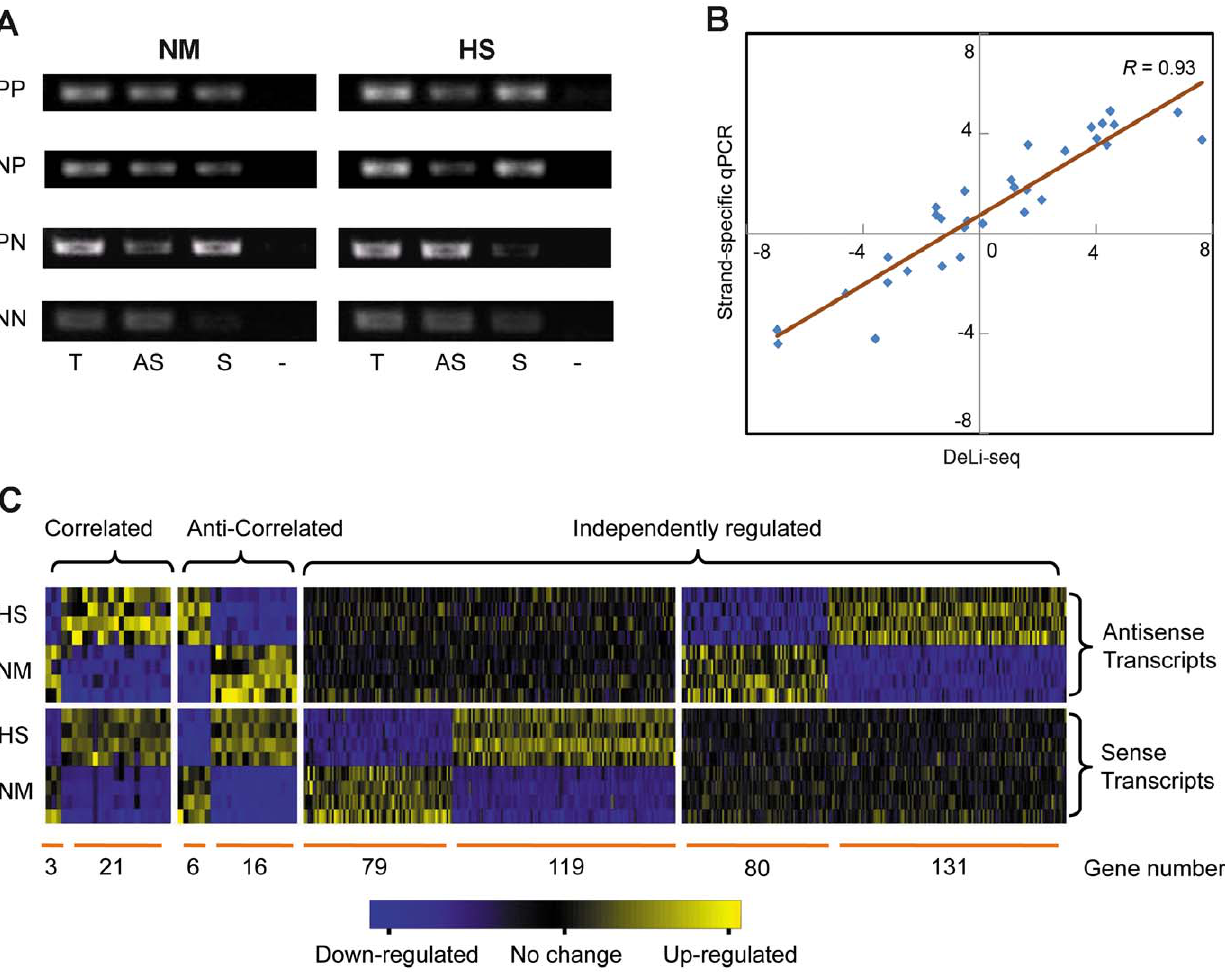
Figure 3. Differentially expressed sense and antisense transcripts. (A) Strand-specific RT-PCR results of four loci selected for validation. PCR products specific to antisense (AS) or sense (S) transcripts are shown. Positive control (T; RT with two gene-specific primers) and negative control (-; no primer at RT step) are also included. PP: S $ AS in both normal (NM) and heat shock (HS) conditions; PN: S $ AS in NM and S , AS in HS; NP: S , AS in NM and S $ AS in HS; NN: S , AS in both NM and HS. (B) Correlation between DeLi-seq and strand-specific qPCR. The log 2 (S/AS) values obtained by DeLi-seq (X axis) and the D Ct values between sense and antisense transcripts determined by quantitative strand-specific RT-PCR (Y axis) were used to compute the correlation coefficient ( R ). (C) Sense and antisense transcripts are either coordinated (correlated or anti-correlated) or independently regulated. The number of genes in each category is shown.